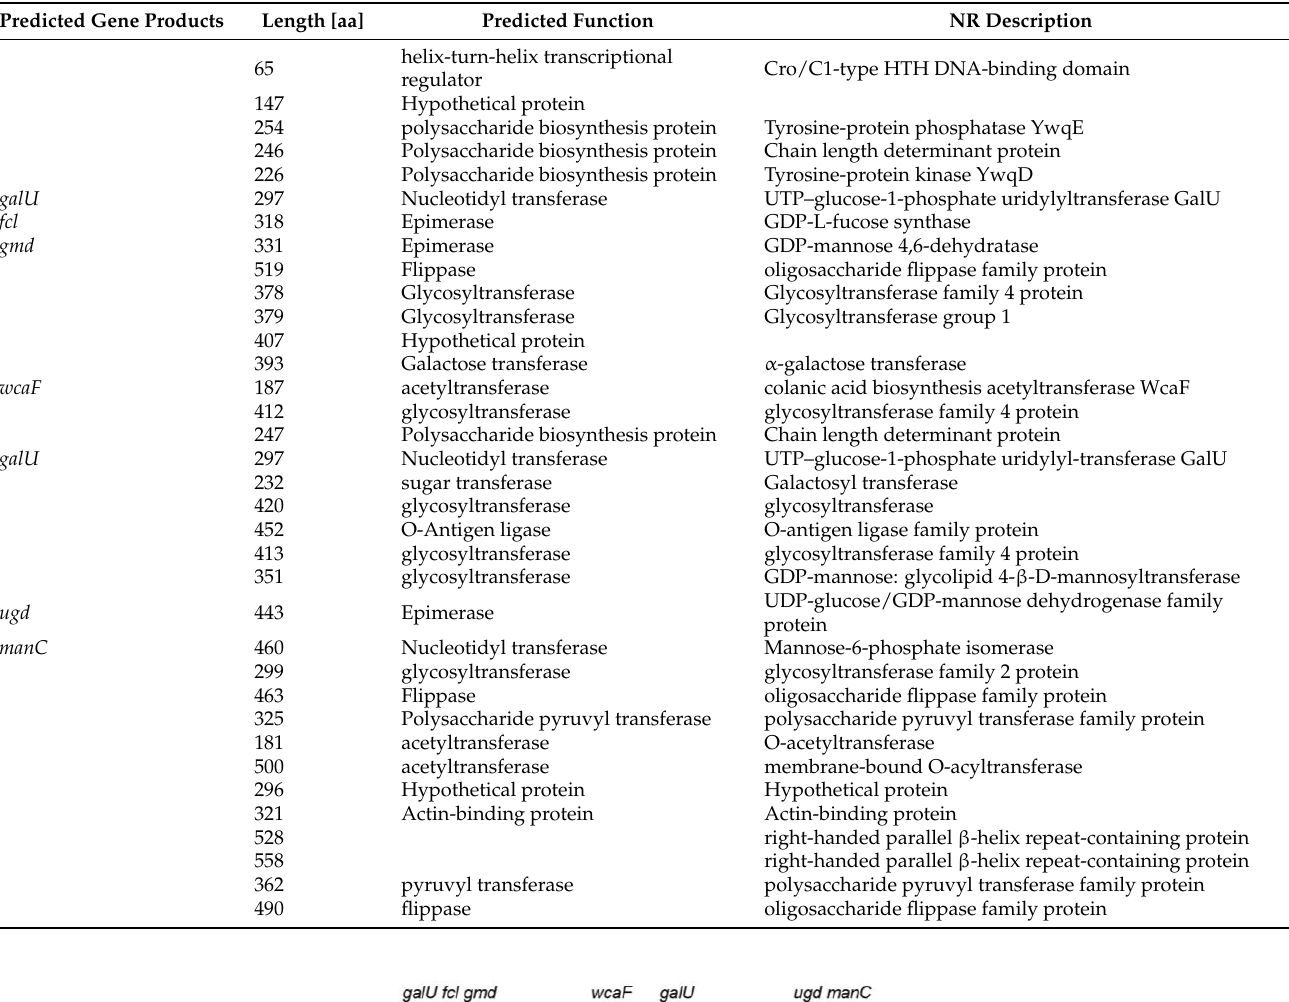
Table 6. Putative exopolysaccharides production-related gene cluster in G78. Predicted Gene Products